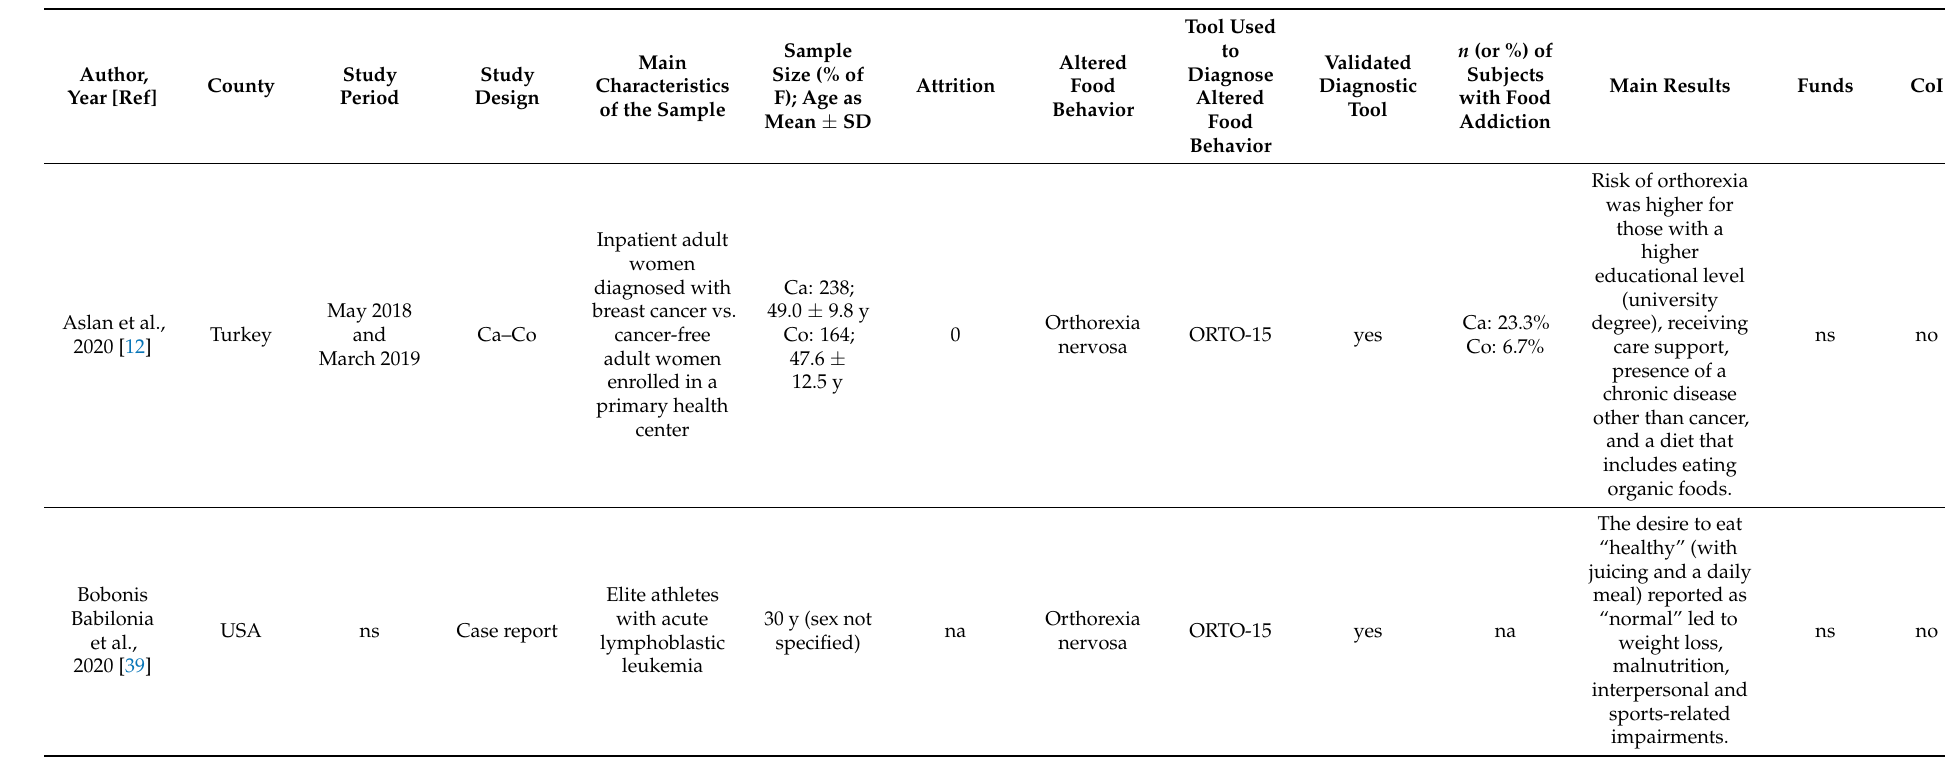
Table 2. Main characteristics of included studies, reported in alphabetical order (surname of the first